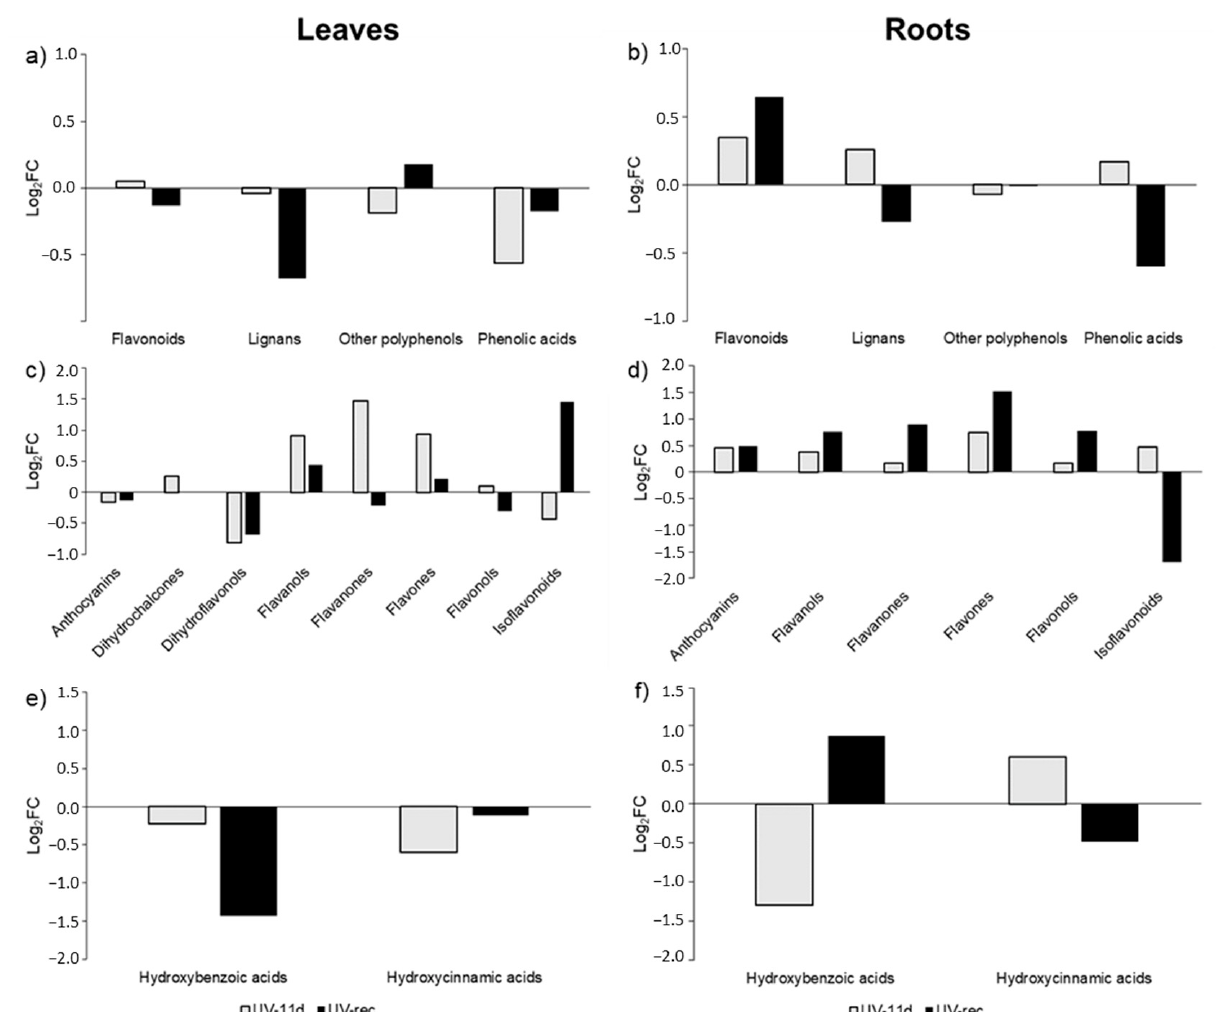
Figure 5. Fold-change (FC) of phenolic accumulation in leaves and roots of UV treated plants at 11 days of treatment and after 3 days of recovery with respect to control plants. Compounds were grouped on the basis of phenolic class ( a , b ), flavonoid ( c , d ), and phenolic acids ( e , f ) subclasses. Data for each biochemical pathway represent the sum of the Log 2 FC of each detected compound.